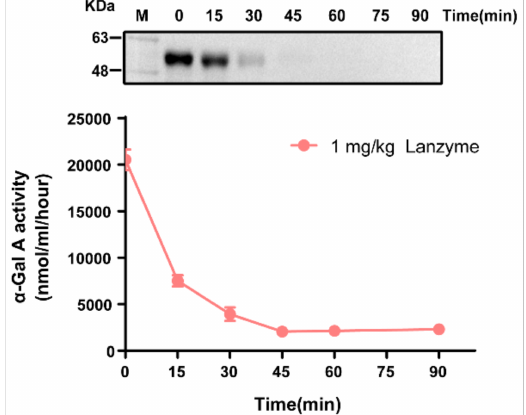
Figure 2. The circulating half-life of Lanzyme. Eight-week-old male wild-type WT mice ( n = 8) were dosed with a single intravenous infusion of 1 mg/kg of Lanzyme. Plasma samples were collected over a 24 h period from the start of the infusion, and Lanzyme ( α -Gal A) activity (lower panel) and protein levels (Western blotting, upper panel) were measured. For the graph, each time point represents the mean ± SEM of the activity measured from eight mice. Each lane of the Western blotting represents a different time point plasma from a single